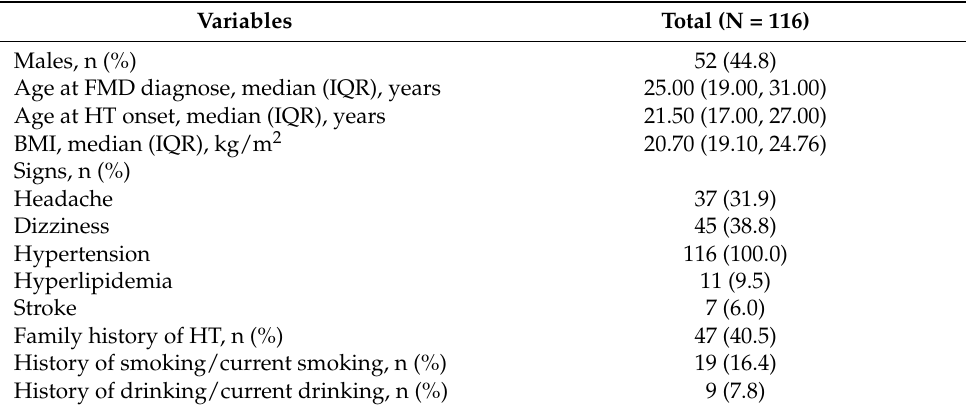
Table 1. Patients’ demographics, symptoms, comorbidities, and family